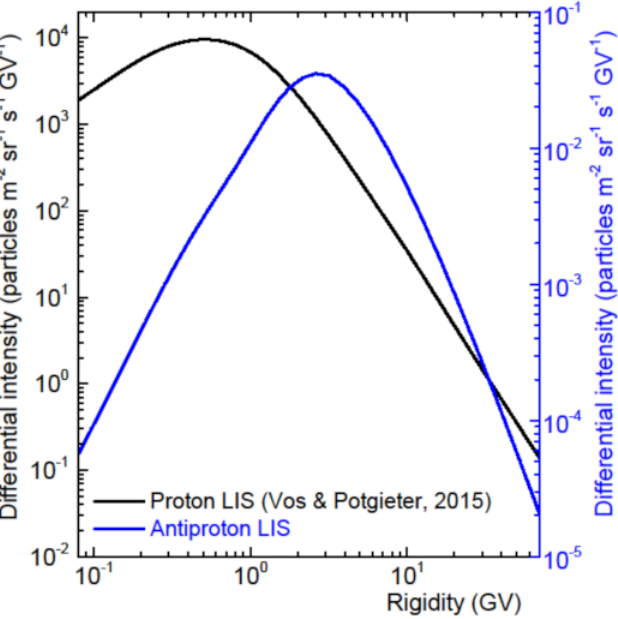
Figure 16. Computed VLISs for galactic protons [46,127] (left-side scale; black line) and for anti- protons (right-side scale; blue line) as a function of rigidity shown here for comparative reasons; apart from the peak values, note the vastly different spectral slopes at both low and high